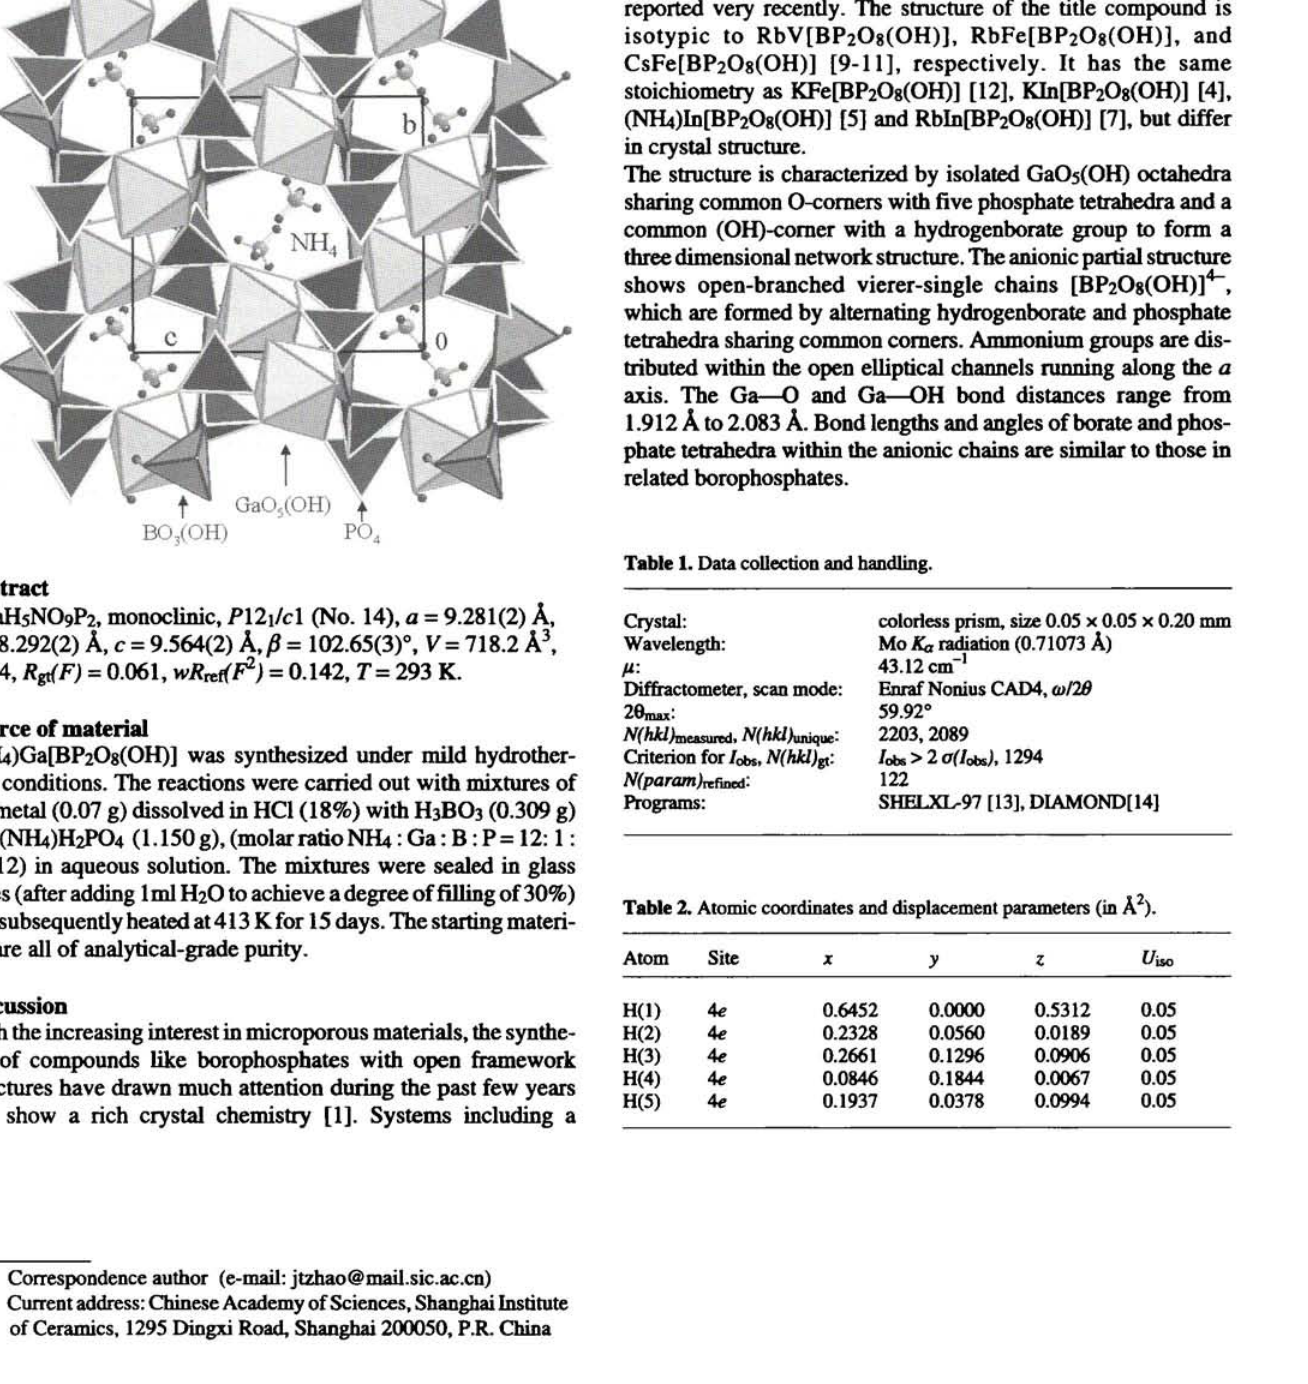
Table 2. Atomic coordinates and displacement parameters (in Ä 2